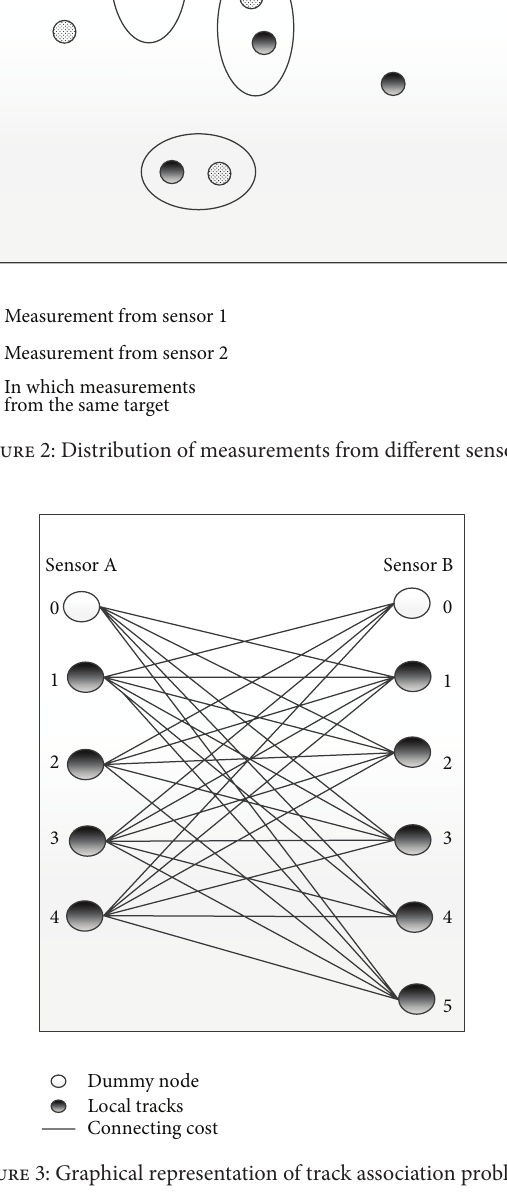
illustrates a scenario with two sensors and six targets. Here, sensor 1 detects 4 targets, and sensor 2 detects 5 targets. That means that 𝑛 1 = 4 , 𝑛 2 = 5 , and there are 3 common